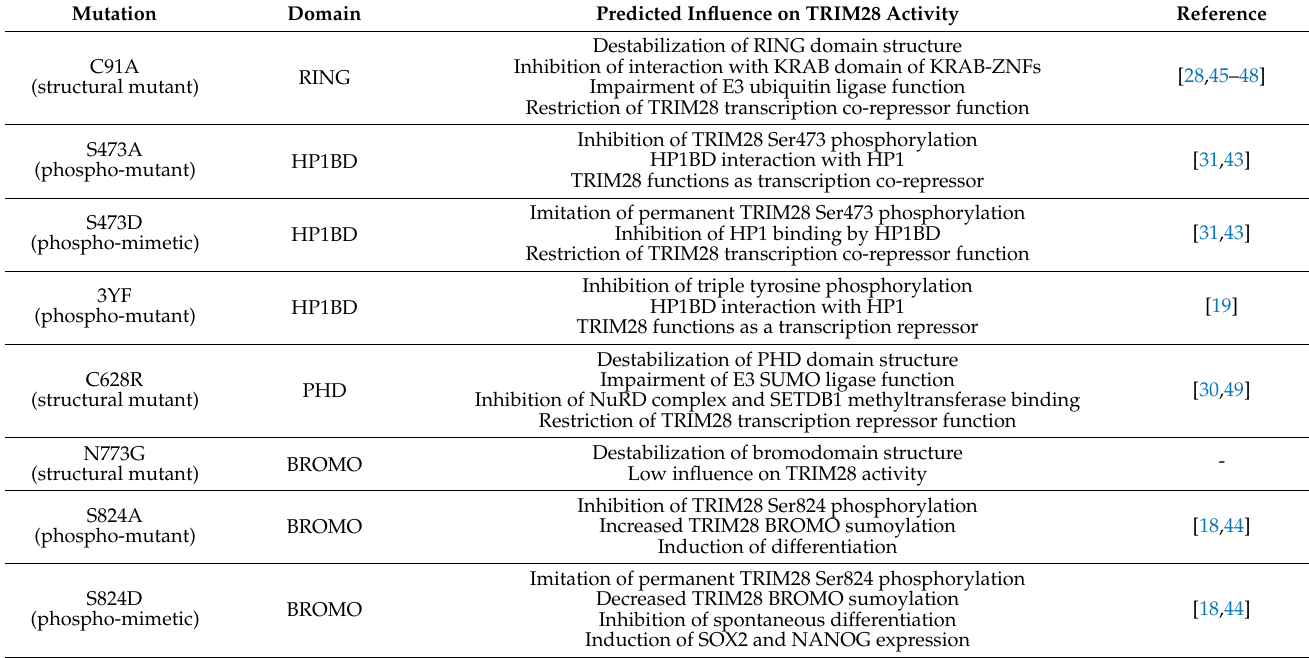
Table 1. Selected TRIM28 mutation sites with predicted effects on protein